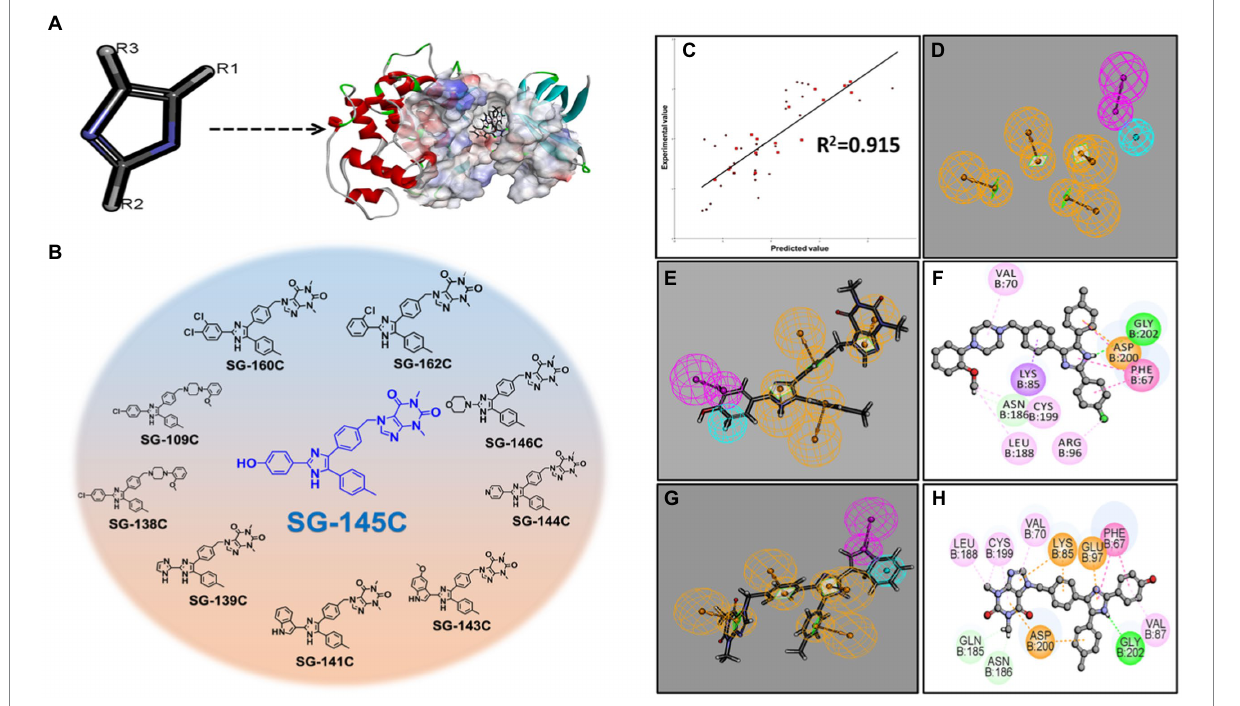
FIGURE 1 Establishment of the pharmacophoric model with GSK-3 β and screening of lead molecules. (A) Projecting imidazole moiety into the GSK-3 β pocket to modulate the scaffold at defined positions. (B) Among the top 10 screened molecule SG-145C stands out to be the best. (C) 3D-Pharmacophoric model showing a correlation coefficient of 0.915. (D) 3D coordinates of ligands with respect to pharmacophoric interactions (E,F) Pharmacophore mapping with the 3D pharmacophore model depicting SG-145C to be the best-fitted molecule. (G,H) Pharmacophore mapping with the 3D pharmacophore model depicting SG-138C to be the 2nd best-fitted